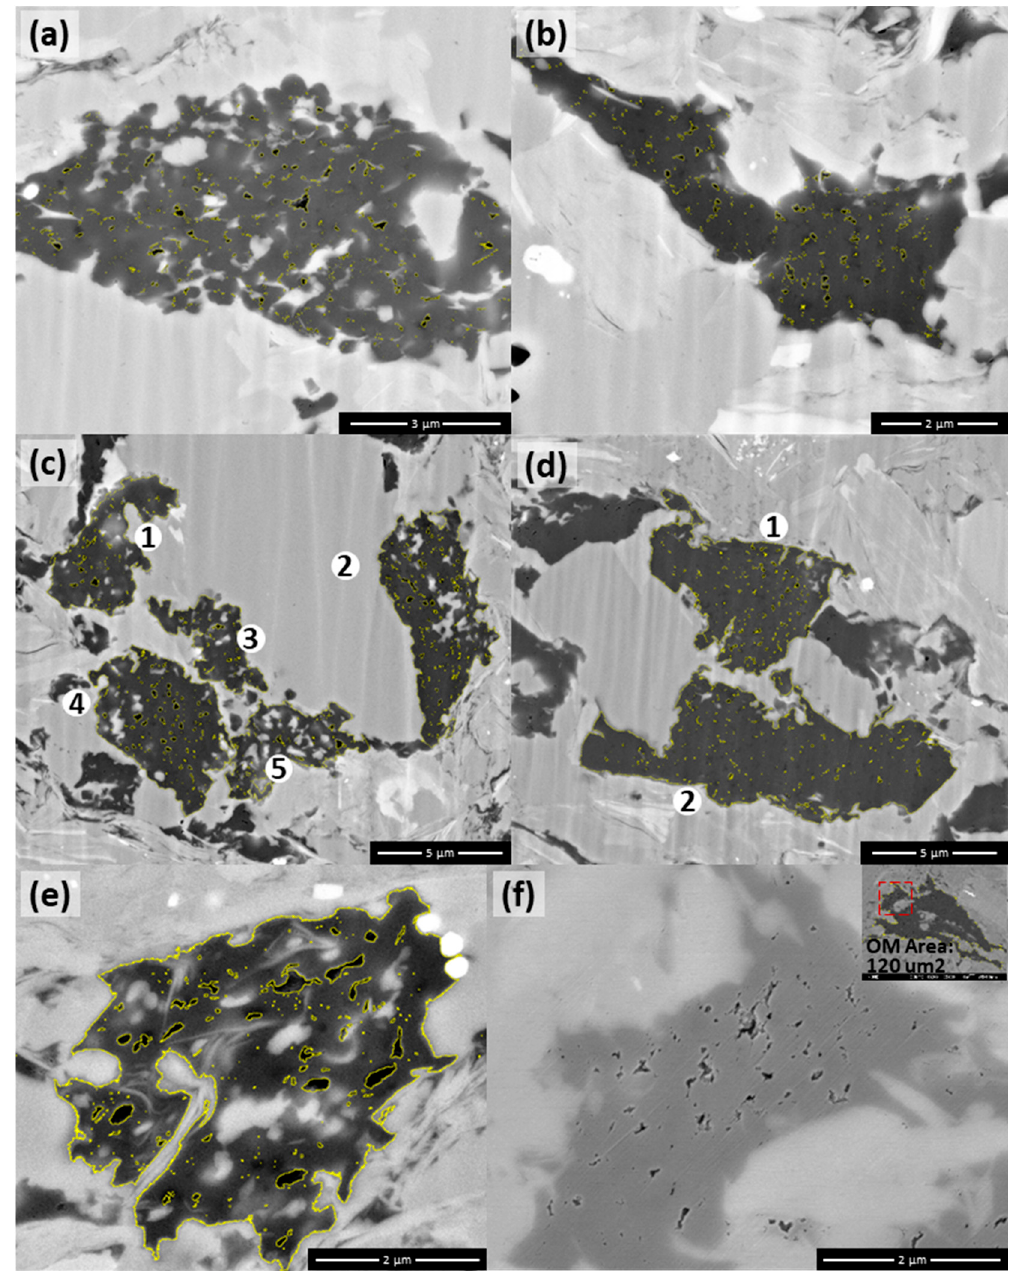
Figure 12. The typical examples of the second subtype of moderately to strongly deformed pyrobitumen (OM V) from Longmaxi-Wufeng Shale, Sichuan Basin. ( a ) SEM image JY8S-3-13 (well ID-sample no.-image no.); ( b ) SEM image JY8S-3-24; ( c ) SEM image JY8S-3-30; ( d ) SEM image JY8S-5-29; ( e ) SEM image JY8S-10-06; and ( f ) SEM image JY1S-4-08. The boundary of OM-hosted pores was outlined by yellow color.